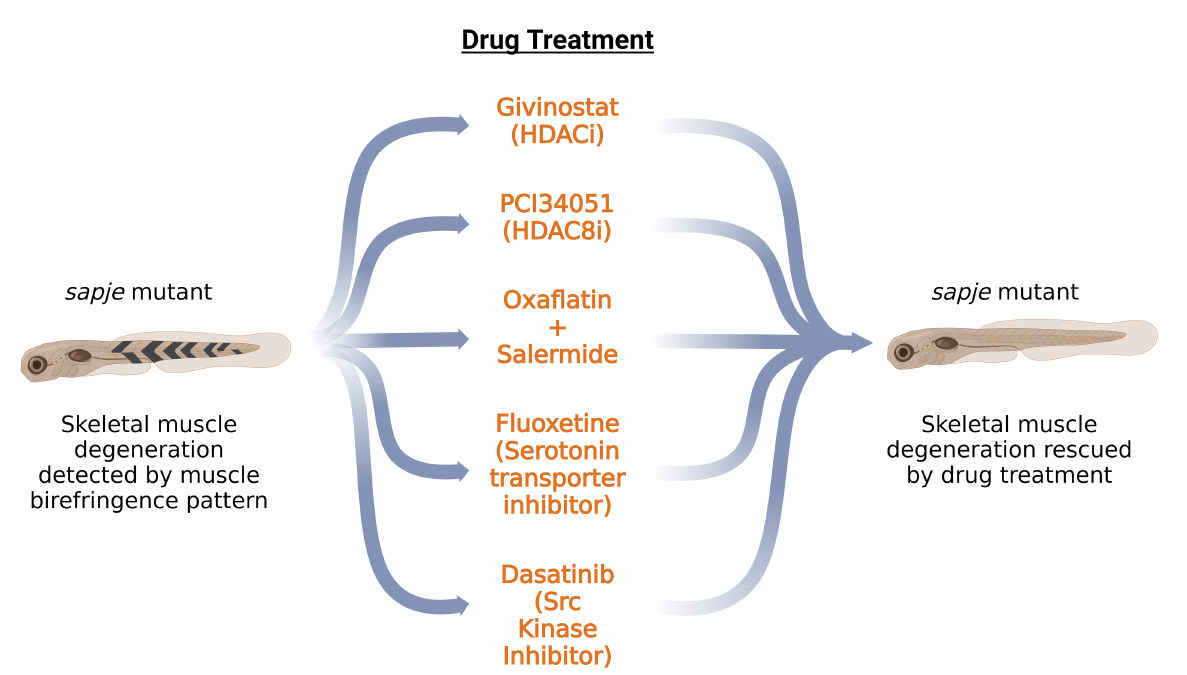
FIGURE 2 Schematic summary of the potential drugs tested on sapje zebrafish DMD model. Application of these drugs on dmd mutant zebrafish rescued the skeletal muscle degeneration as observed by the muscle birefringence pattern. HDACi: Histone Deacetylase inhibitor; HDAC8i: Histone Deacetylase 8